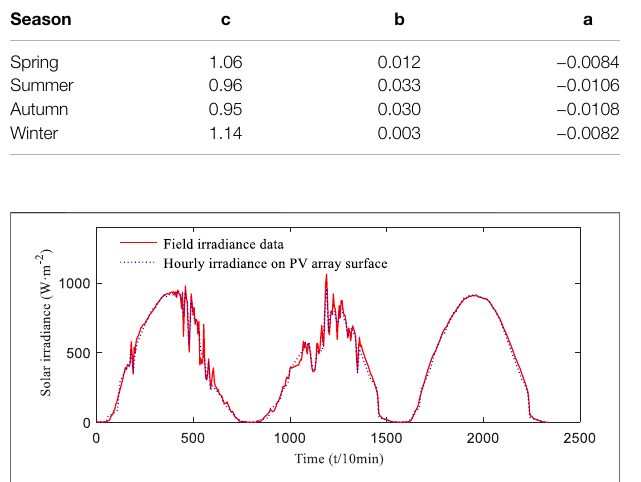
FIGURE 2 | Hourly irradiance on PV array surface in forecasting days.